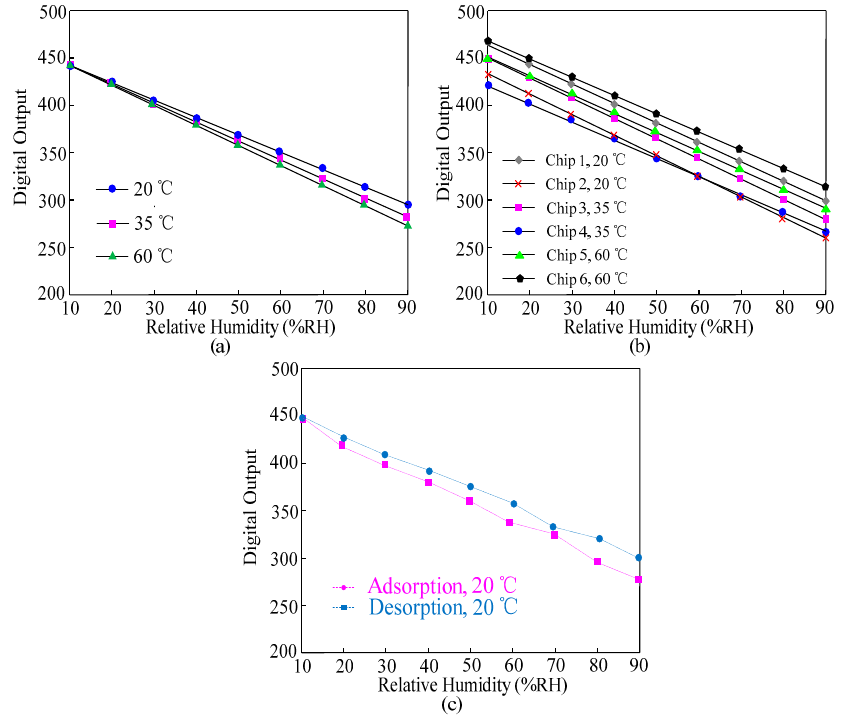
Figure 16. Measured humidity performances of the wireless sensor: ( a ) digital outputs at 20 °C, 35 °C, and 60 °C; ( b ) digital outputs of five test chips at 20 °C, 35 °C, and 60 °C; ( c ) hysteresis performances at 20 °C.